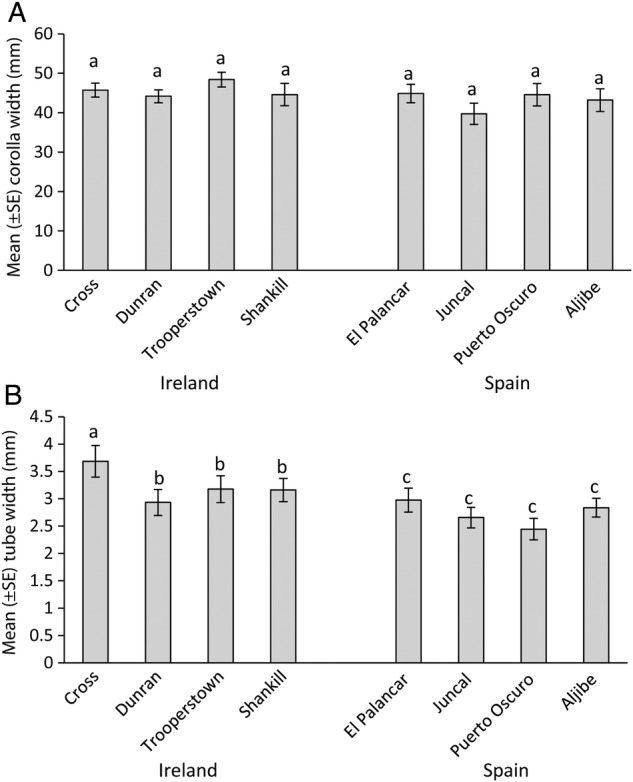
Mean (±SE) (A) corolla width in millimetre and (B) tube width in millimetre of flowers from each population within each region (Ireland and Spain). Means were calculated from five flowers from each of five plants within each population, and then for the population. Letters above scale bars correspond to the results of multiple comparison tests (SNK, P< 0.05).